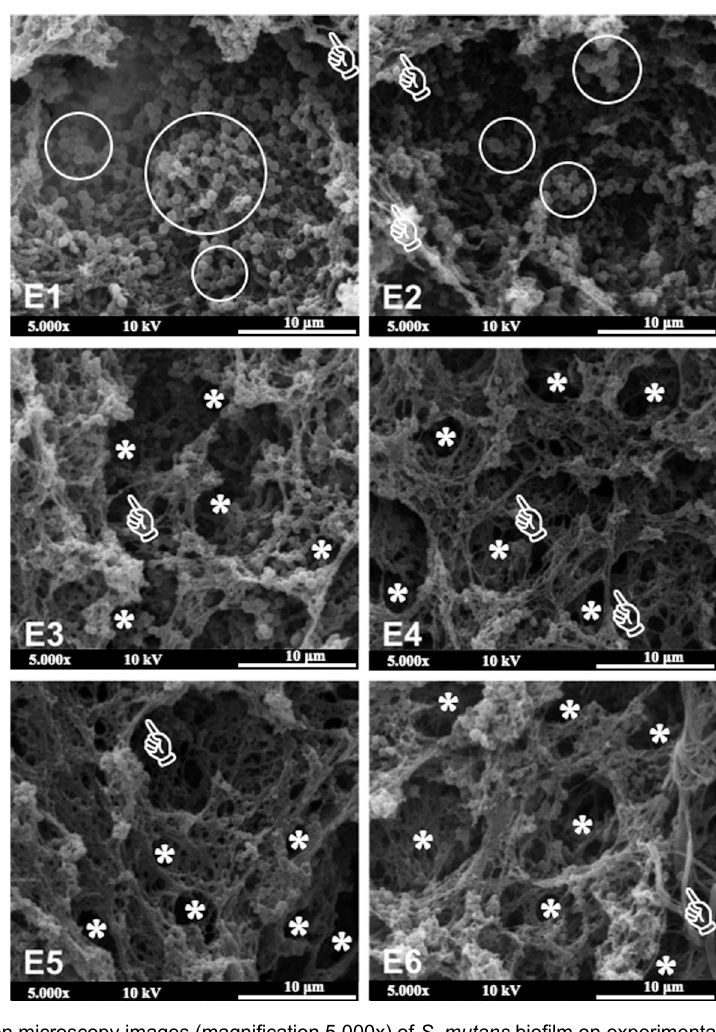
Figure 4- Scanning electron microscopy images (magnification 5,000x) of S. mutans biofilm on experimental composite surfaces